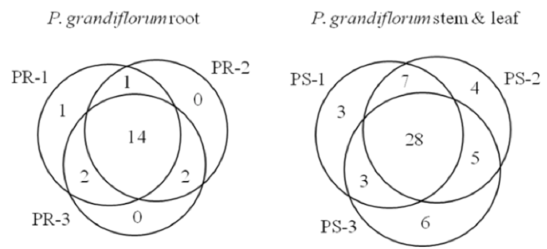
Figure 2. Venn diagram of metabolites analyzed in three P. grandiflorum roots (PRs) and three P. grandiflorum stems and leaves (PSs) (ESI-).